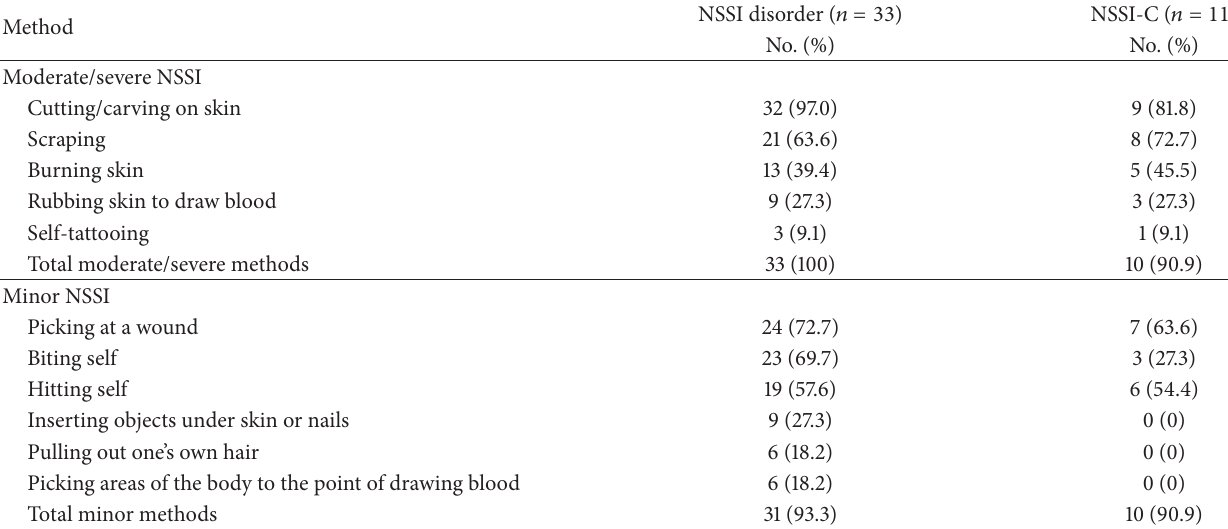
Table 3: Frequency of methods of self-injurious behaviour assessed by the FASM in adolescents with NSSI (NSSI disorder) and adolescents with NSSI without impairment/distress (NSSI-C).